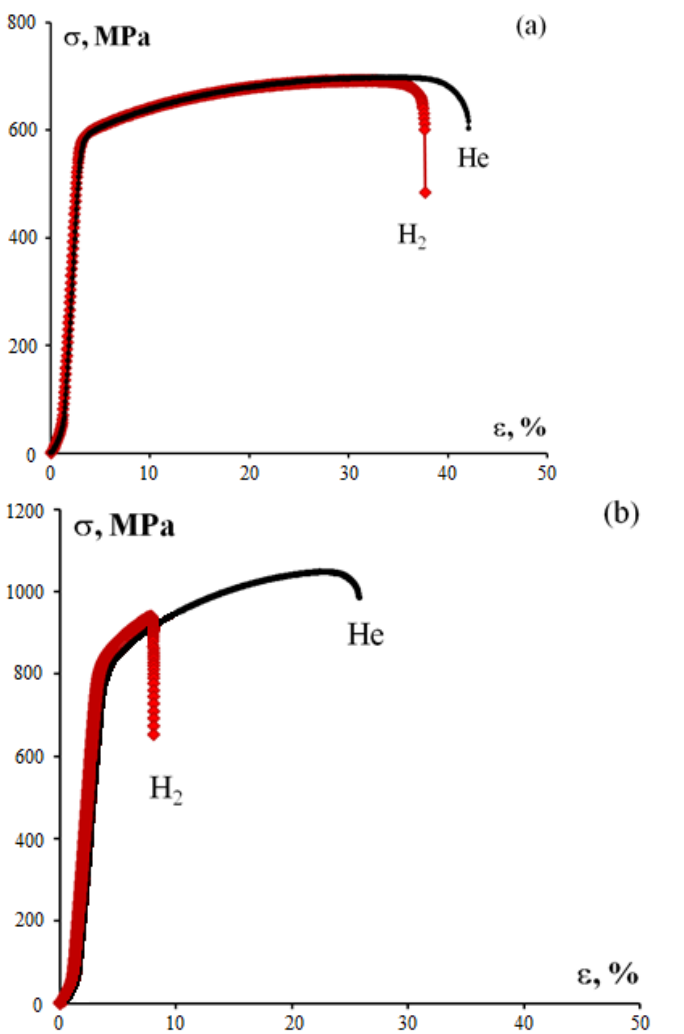
Figure 5. Stress–strain diagrams in helium and in hydrogen for 316L steel ( a ) and Inconel 718 alloy ( b ) specimens.